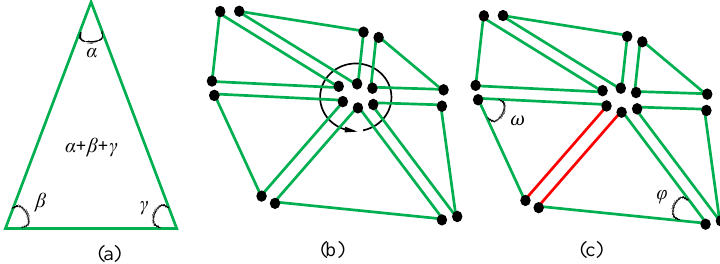
Figure 3. Three kinds of mesh-topology constraints in mesh parameterization: ( a ) triangle consistency, ( b ) vertex consistency, and ( c ) wheel consistency.